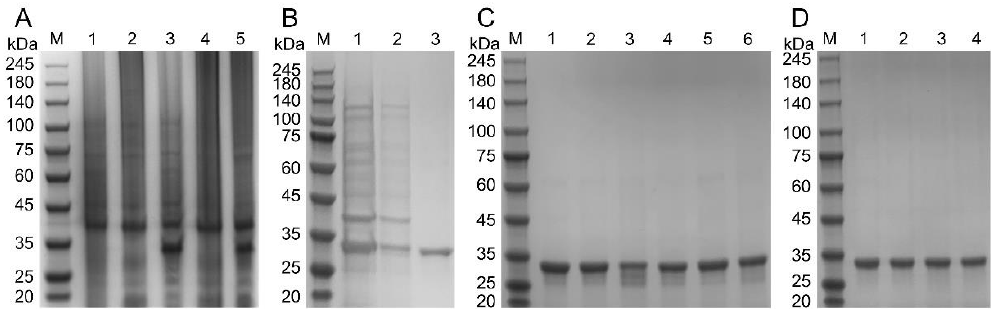
Figure 1. Expression and purification of the RBD protein mutants. ( A ) Lane 1: total protein of wild Enterobacter; Lane 2: total protein of uninduced recombinant strain; Lane 3: total protein of the recombinant strain after induction; Lane 4: supernatant protein after ultrasonic enucleation; Lane 5: precipitated protein after ultrasonic enucleation. ( B ) Lane 1: 8M urea dissolved total inclusion body protein; Lane 2: unbound protein collection solution; Lane 3: recombinant RBD protein collection solution. ( C , D ) SDS-PAGE analysis of denatured, renatured, and concentrated recombinant RBD protein and mutant protein. ( C ) Lane 1: mutant K417T; Lane 2: mutant K417N, Lane 3: mutant L452R; Lane 4: mutant E484K; Lane 5: mutant E484Q; Lane 6: mutant N501Y. ( D ) Lane 1: wild-type RBD protein; Lane 2: mutant L452R-E484Q; Lane 3: mutant K417T-E484K-N501Y; Lane 4: mutant